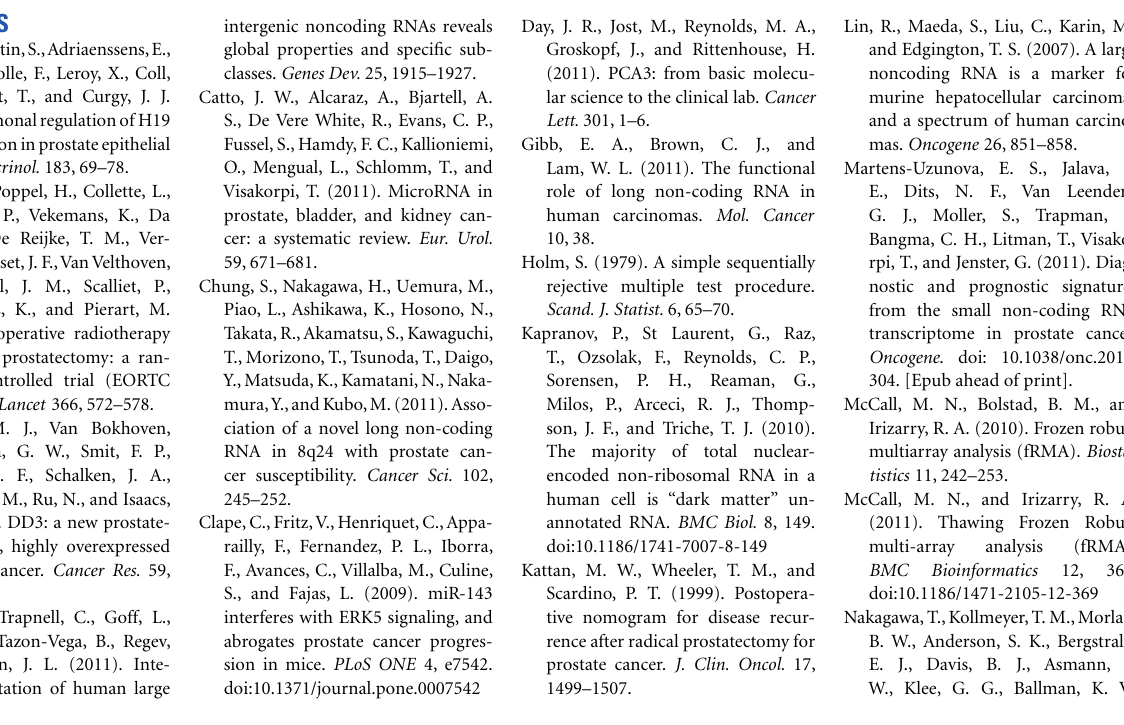
Table S1 |Top 100 differentially expressed exonic and non-exonic features for each pairwise comparison. The features were ranked according to their adjusted p -value. Table S2 | Gene ontology and pathway enrichment analysis for all, up-regulated and down-regulated